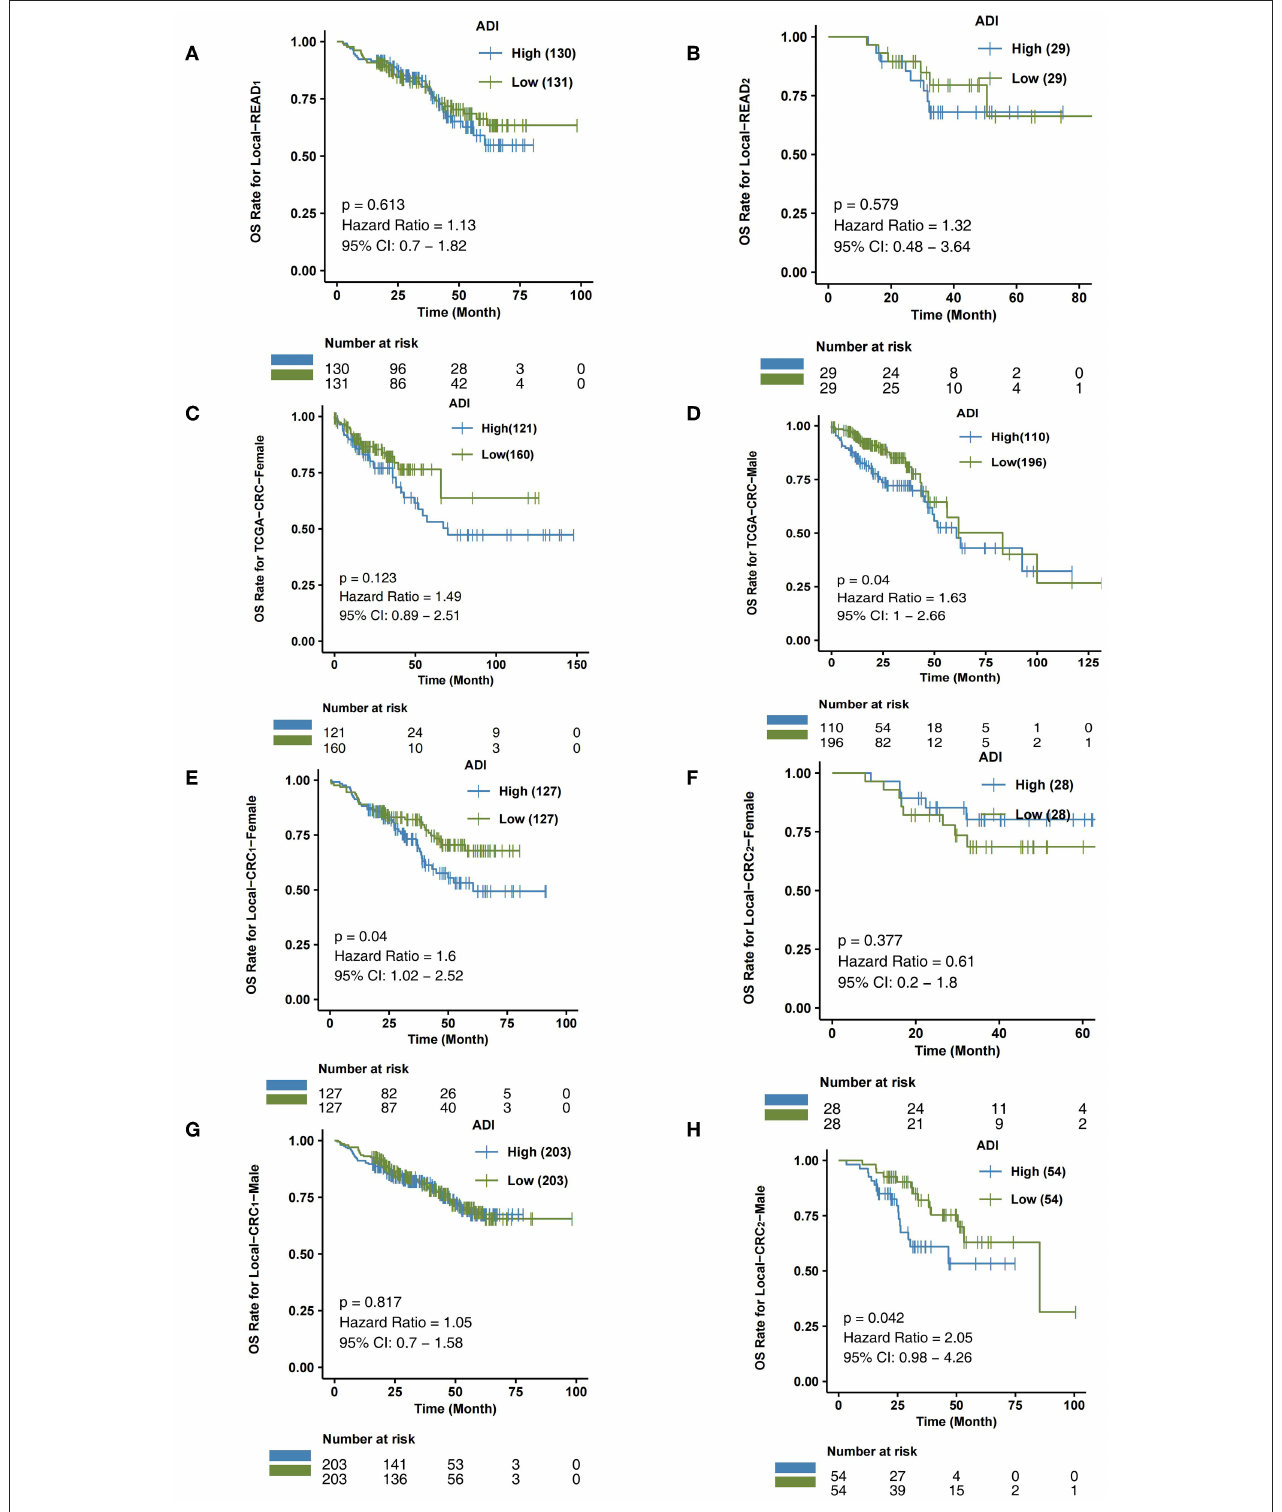
FIGURE 4 | The association between ADI and OS of CRC subgroups. Overall survival for subjects grouped according to ADI subclass (high-ADI and low-ADI) in the queues Local-READ1 (A) and Local-READ2 (B) , TCGA-CRC-Female (C) , TCGA-CRC-Male (D) , Local-CRC1-Female (E) , Local-CRC2-Male (F) , Local-CRC1-Female (G) , and Local-CRC2-Male (H)